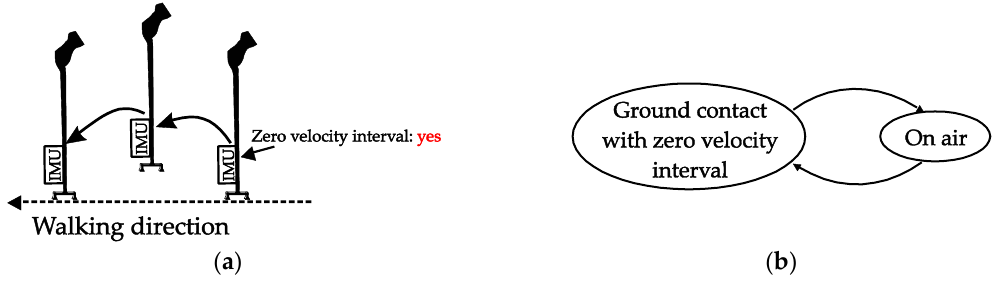
Figure 3. Quadripod cane movement: ( a ) Visualization; ( b ) State diagram.